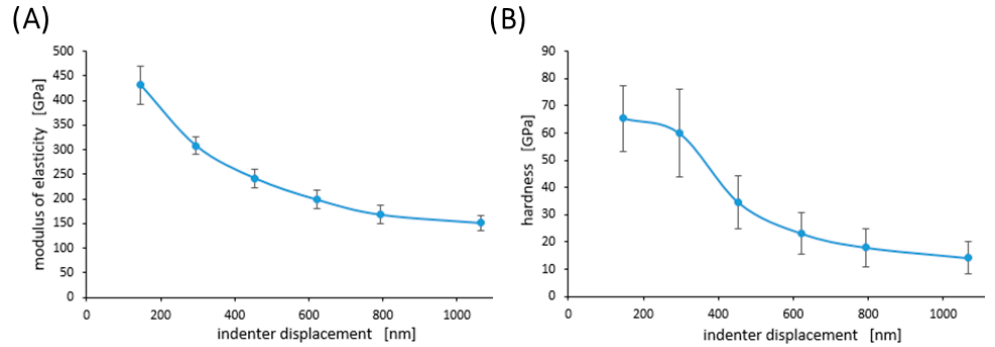
Figure 7. Profiles of hardness (H)—( A ), and modulus of elasticity (E)—( B ) for diamond nanosheet. Error bars represent ± standard deviation.